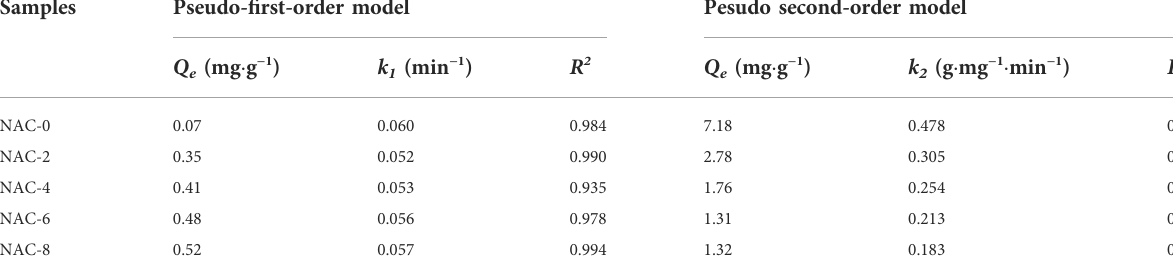
TABLE 4 Fitting parameters of Pesudo fi rst-order model and Pesudo second-order model. Samples